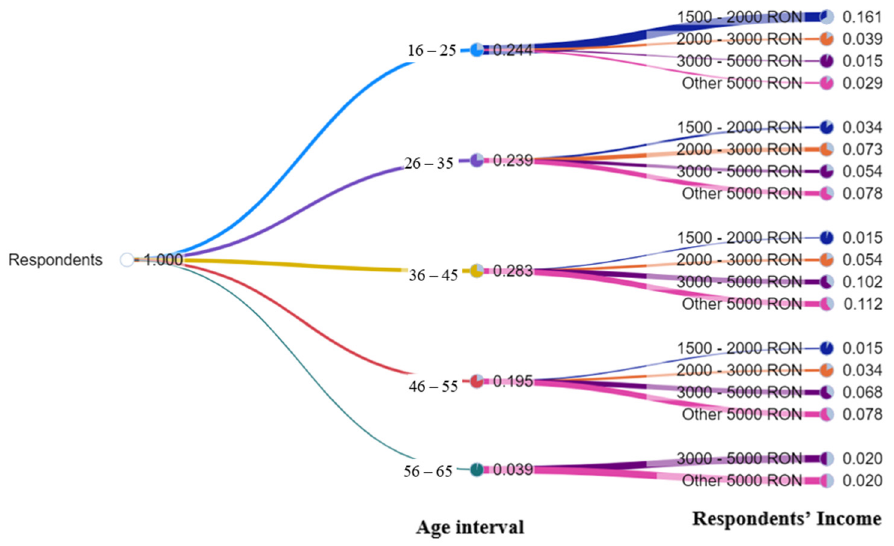
Figure 2. Social profile of the respondents (Source: Own projection according to the answers of the applied questionnaire).